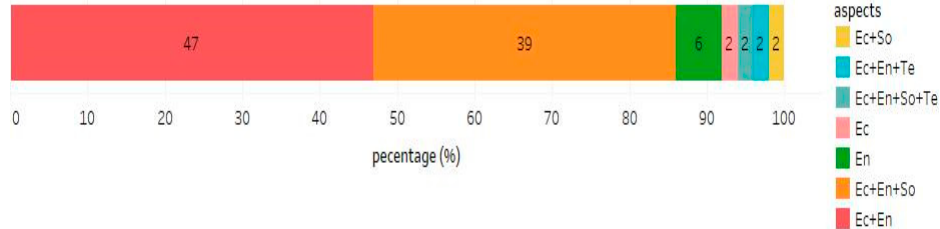
Figure 5. Distribution of publications based on aspect. Ec+So (economical and social); Ec+En+Te (economic, environ- mental, and technical); Ec+En+So+Te (economic, environmental, social, and technical); Ec (economical); En (environ- mental); Ec+En (economical and environmental).